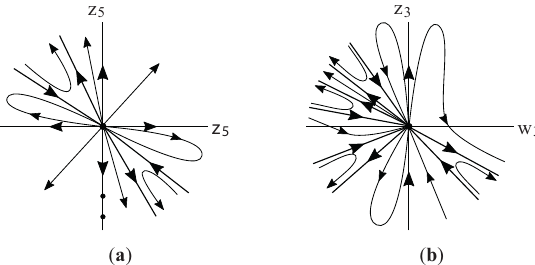
(a) Origin of ( ,Q ). (b) Origin of ( ,Q ).